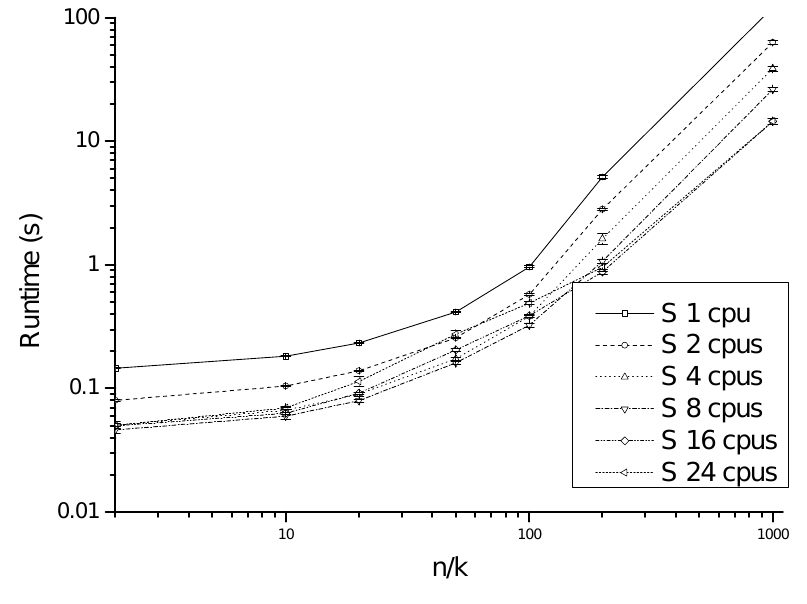
Figure 1. Average runtime of our proposed algorithm for n = 10,000 and multiple values of k and multiple numbers of